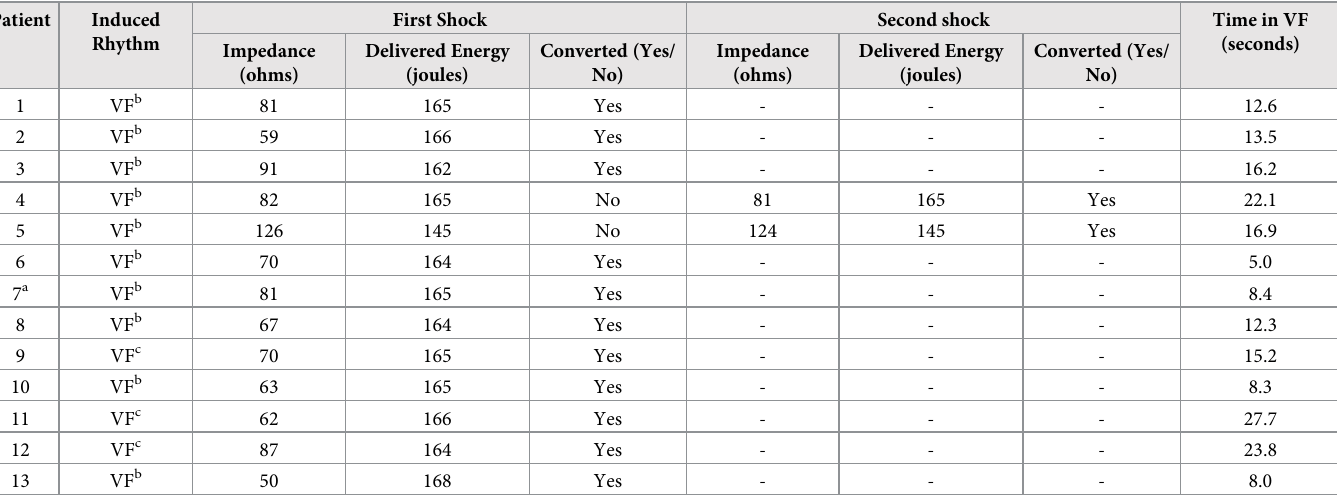
Table 6. Human study defibrillation test